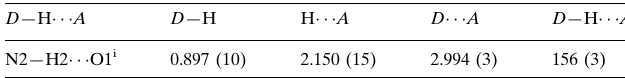
Hydrogen-bond geometry (A˚ , (cid:1)